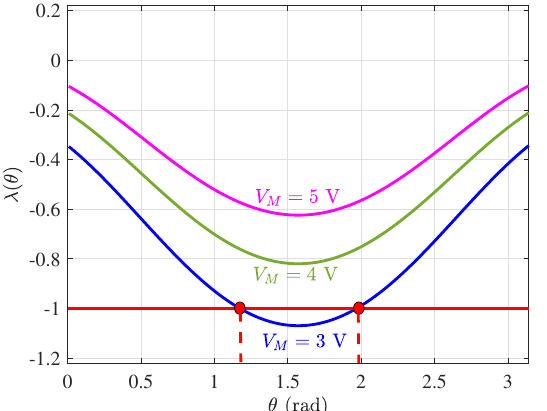
Figure 10. The eigenvalue λ ( θ ) as the phase angle is varied within ( 0, π ) for different values of V M